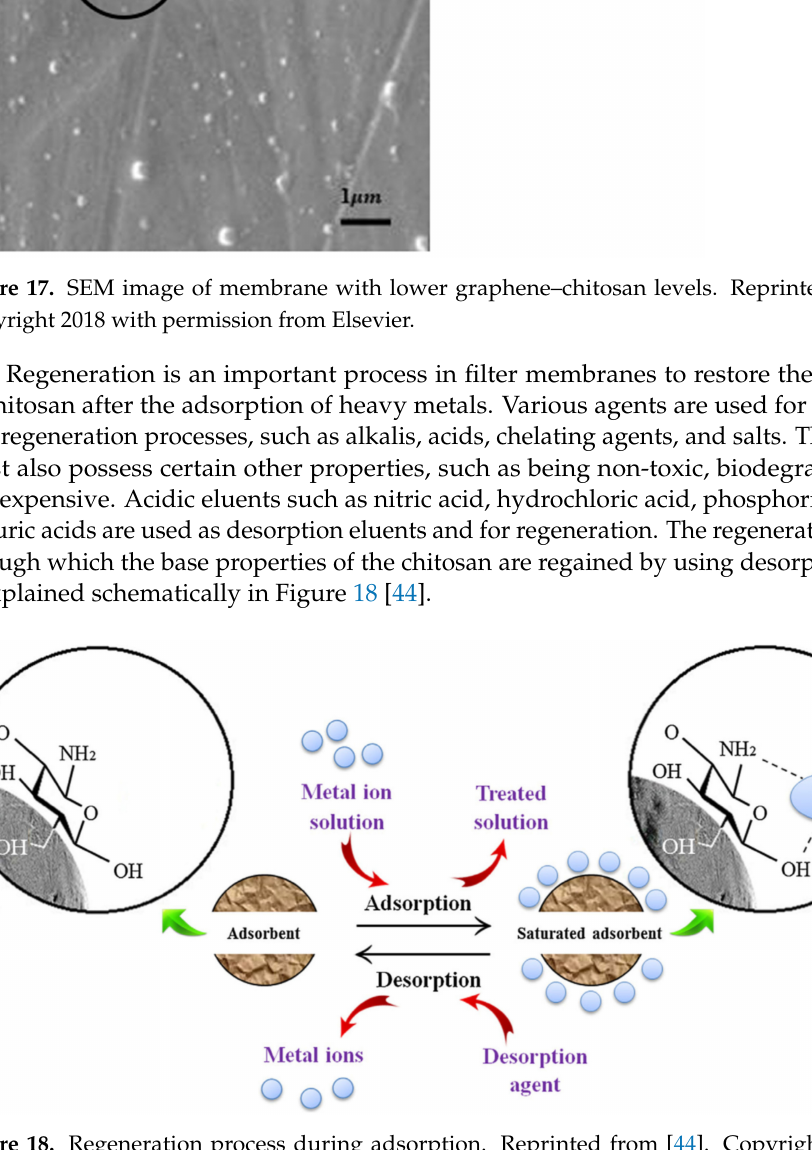
Figure 18. Regeneration process during adsorption. Reprinted from [44]. Copyright 2019 with permission from